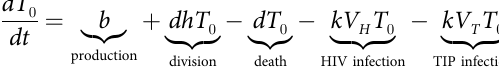
* As in Table I, the above parameters are dimensionless. For their de fi nitions in terms of raw model parameters, and the full list of raw parameters, see S1 Text (Sec. A and